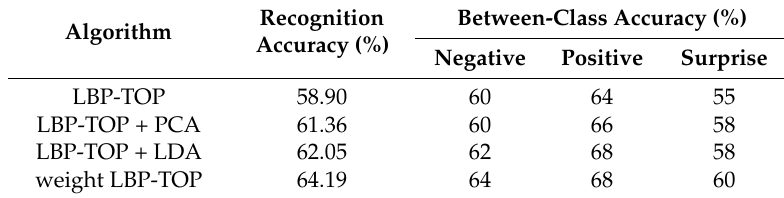
Table 9. Comparison of dimension reduction results